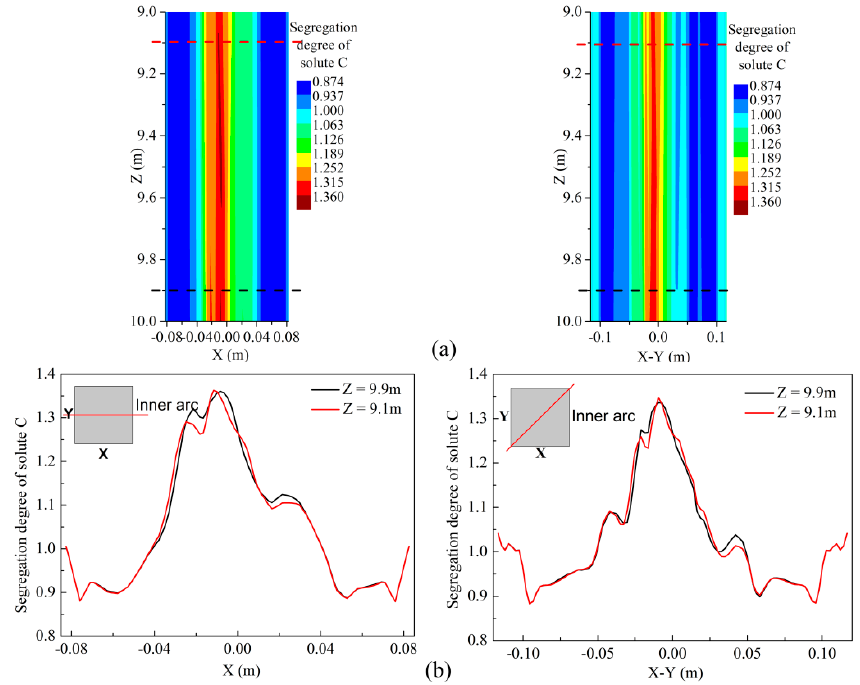
Figure 10. Segregation degree of solute C near the end of solidification: ( a ) contour plots; and ( b ) segregation profiles.